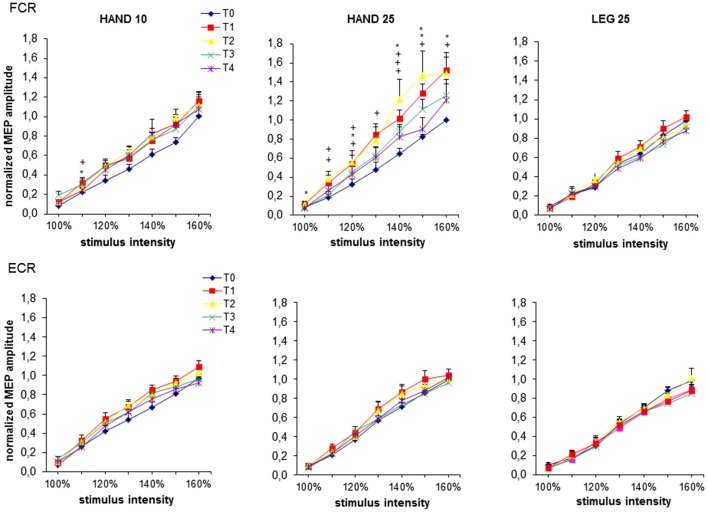
MEP recruitment curves at baseline (T0), immediately after (T1), 0.5 h (T2), 1 h (T3) and 2 h (T4) after 20 min rPMS. Upper plots represent the results from the flexor carpi radialis (FCR), lower plots represent the results from the extensor carpi radialis (ECR). MEPs are normalized to the maximum mean MEP at T0 from each subject individually and then pooled for all subjects for each rPMS separately. For each stimulus intensity mean and standard error of mean (SEM) of the normalized MEP amplitude is plotted. The significant differences between T0 and the corresponding post stimulation assessment are presented (*p < 0.05; +p < 0.01).